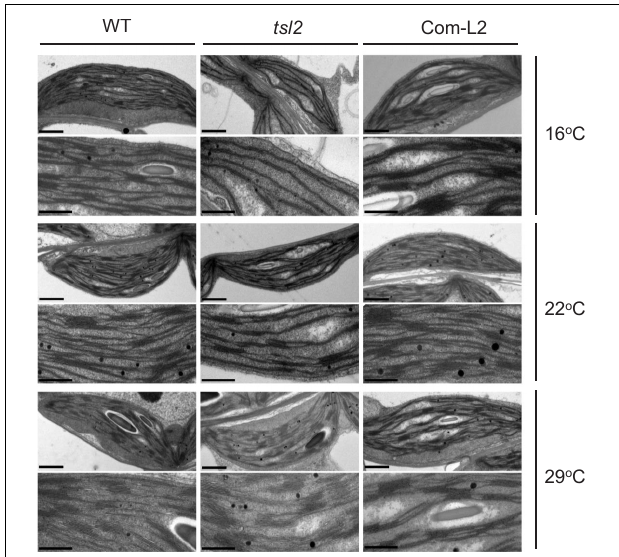
FIGURE 3 | The temperature-associated chloroplast developmental defects of tsl2 mutant are rescued by TSL2 / FtsHi5 . Wild-type (WT), tsl2 mutant, and genetically complemented transgenic plant (Com-L2) grown under normal growth temperature (22 ◦ C) for 4 days were kept at 22 ◦ C or transferred to 16 or 29 ◦ C for 10 days, and then the ultrastructure of chloroplasts was examined under transmission electron microscopy. Scale bars, 1 µ m (upper), 0.5 µ m